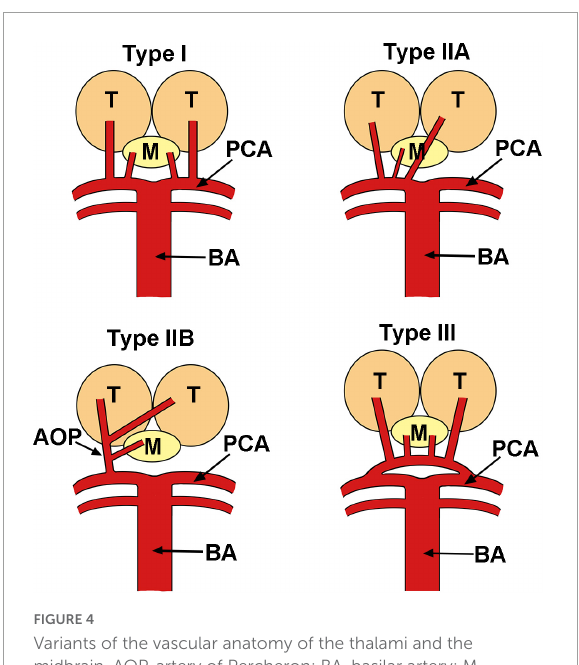
FIGURE4 Variants of the vascular anatomy of the thalami and the midbrain. AOP, artery of Percheron; BA, basilar artery; M, midbrain; PCA, posterior cerebral artery; T,